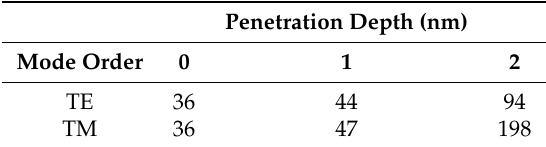
Figure 1. ( a ) Planar waveguide scheme; and ( b ) waveguide thickness d versus effective refractive index N ef up to third-order guided modes ( n 2 , n 3 denote refractive indices of planar waveguide and GGG substrate, respectively). Table 1. Penetration depth of several guided modes (550 nm waveguide layer thickness) into the GGG substrate.